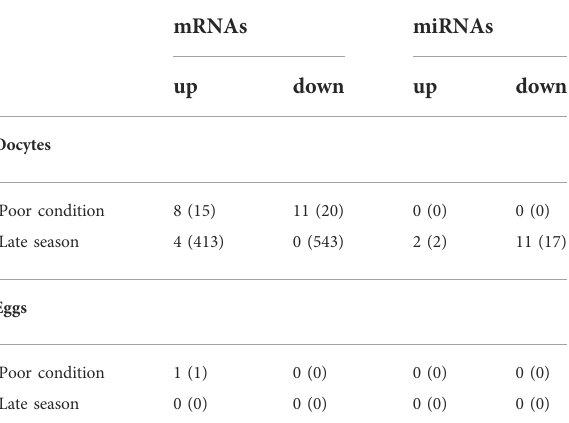
TABLE 1 Number of differentially expressed mRNAs and miRNAs at a threshold of a BH-adjusted p < 0.05 and (in parentheses) p <